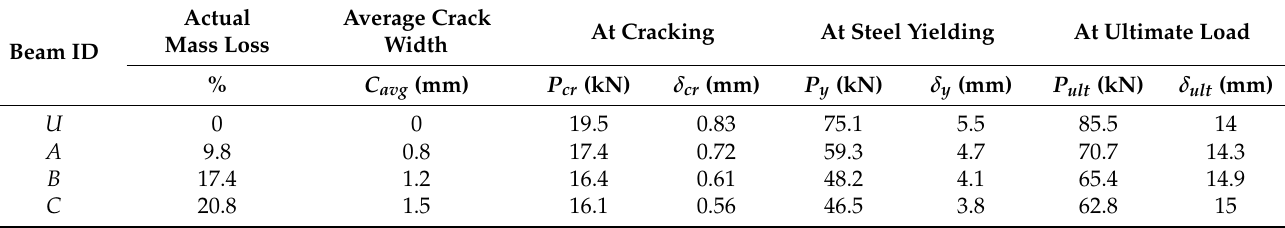
Table 1. Summary of the flexural testing results.